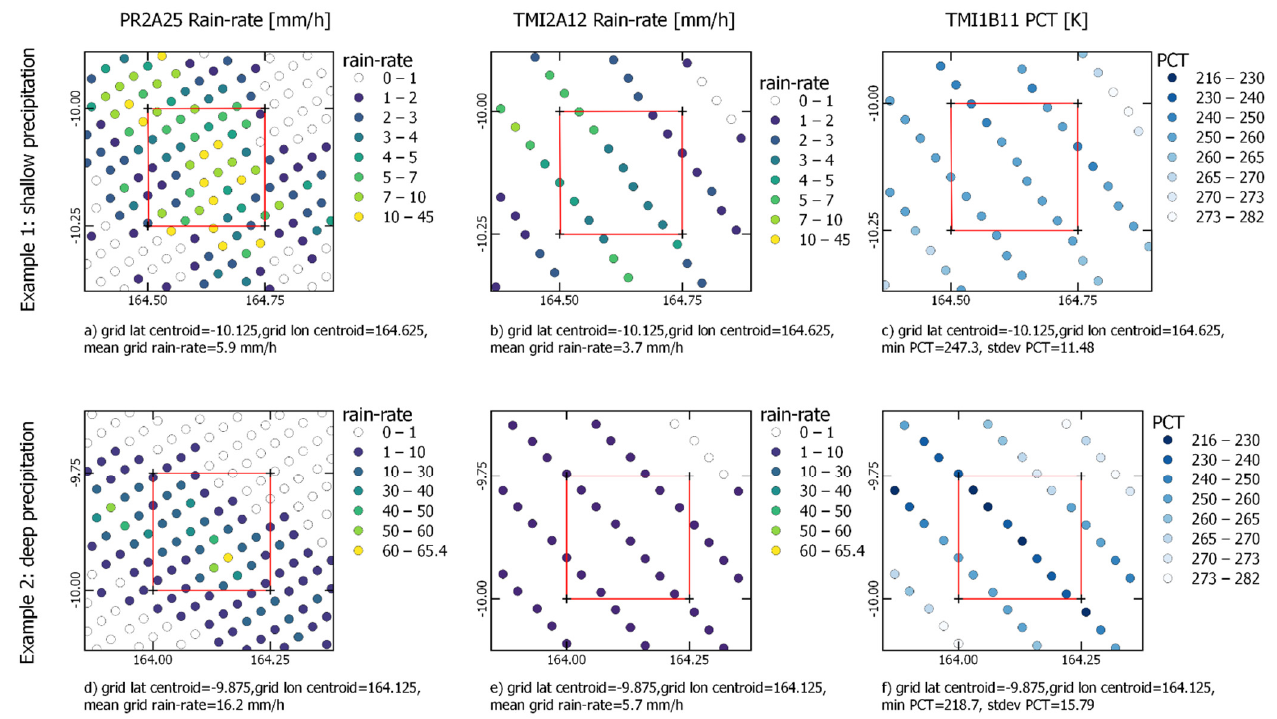
Figure 1. Example of ( a ) PR rain-rate estimation, ( b ) TMI rain-rate estimation, and ( c ) TMI 85 GHz PCT for a precipitation event captured by TRMM at the same coordinate and time. The red bounding box shows a 0.25° × 0.25° grid as the basis of comparison. Note that the 1st example ( a – c ) at the top has a warmer PCT (indicating a shallow precipitation system) than the 2nd example ( d – f ) at the bottom (indicating a deep precipitation system).